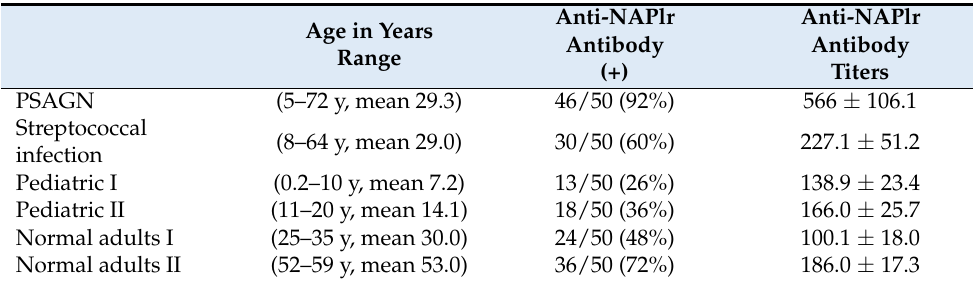
Table 3. Anti-NAPlr antibody in the patients with PSAGN, Group A streptococcal infection without renal involvement, pediatric children, and normal adults